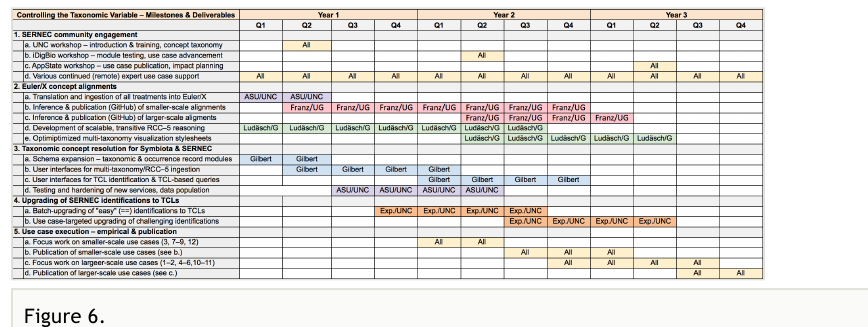
Project management time line; see also Sections 5 & 8. G = graduate student; UG = undergraduate